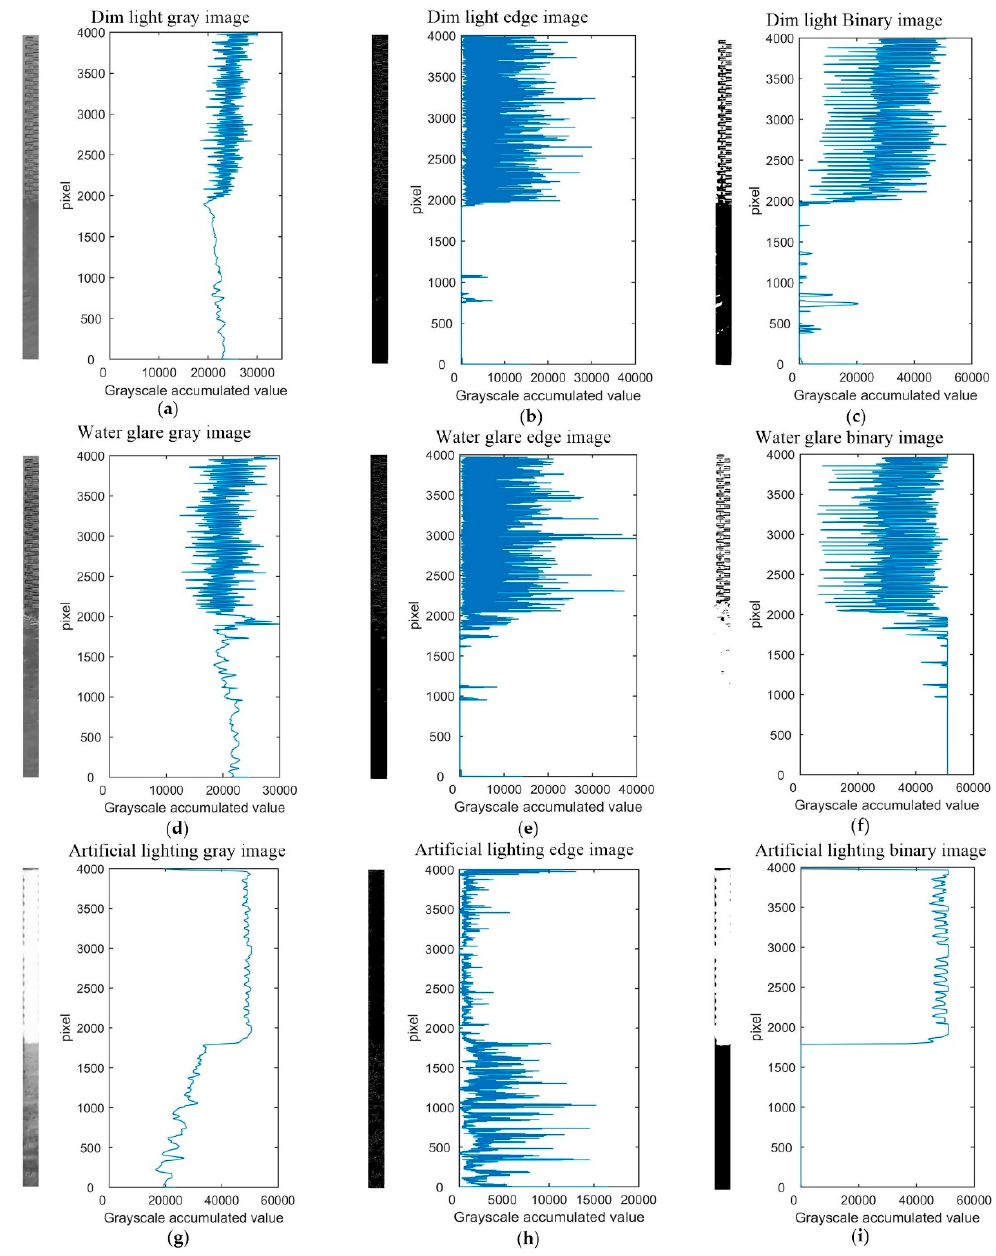
Figure 5. Horizontal projection curves of water gauge orthophotos under three illumination conditions: ( a ) dim light gray image; ( b ) dim light edge image; ( c ) dim light binary image; ( d ) water glare gray image; ( e ) water glare edge image; ( f ) water glare binary image; ( g ) artificial lighting gray image; ( h ) artificial lighting edge image; ( i ) artificial lighting binary image. Table 1. Detection results of water line position in water gauge orthophotos under three illumination conditions (unit: